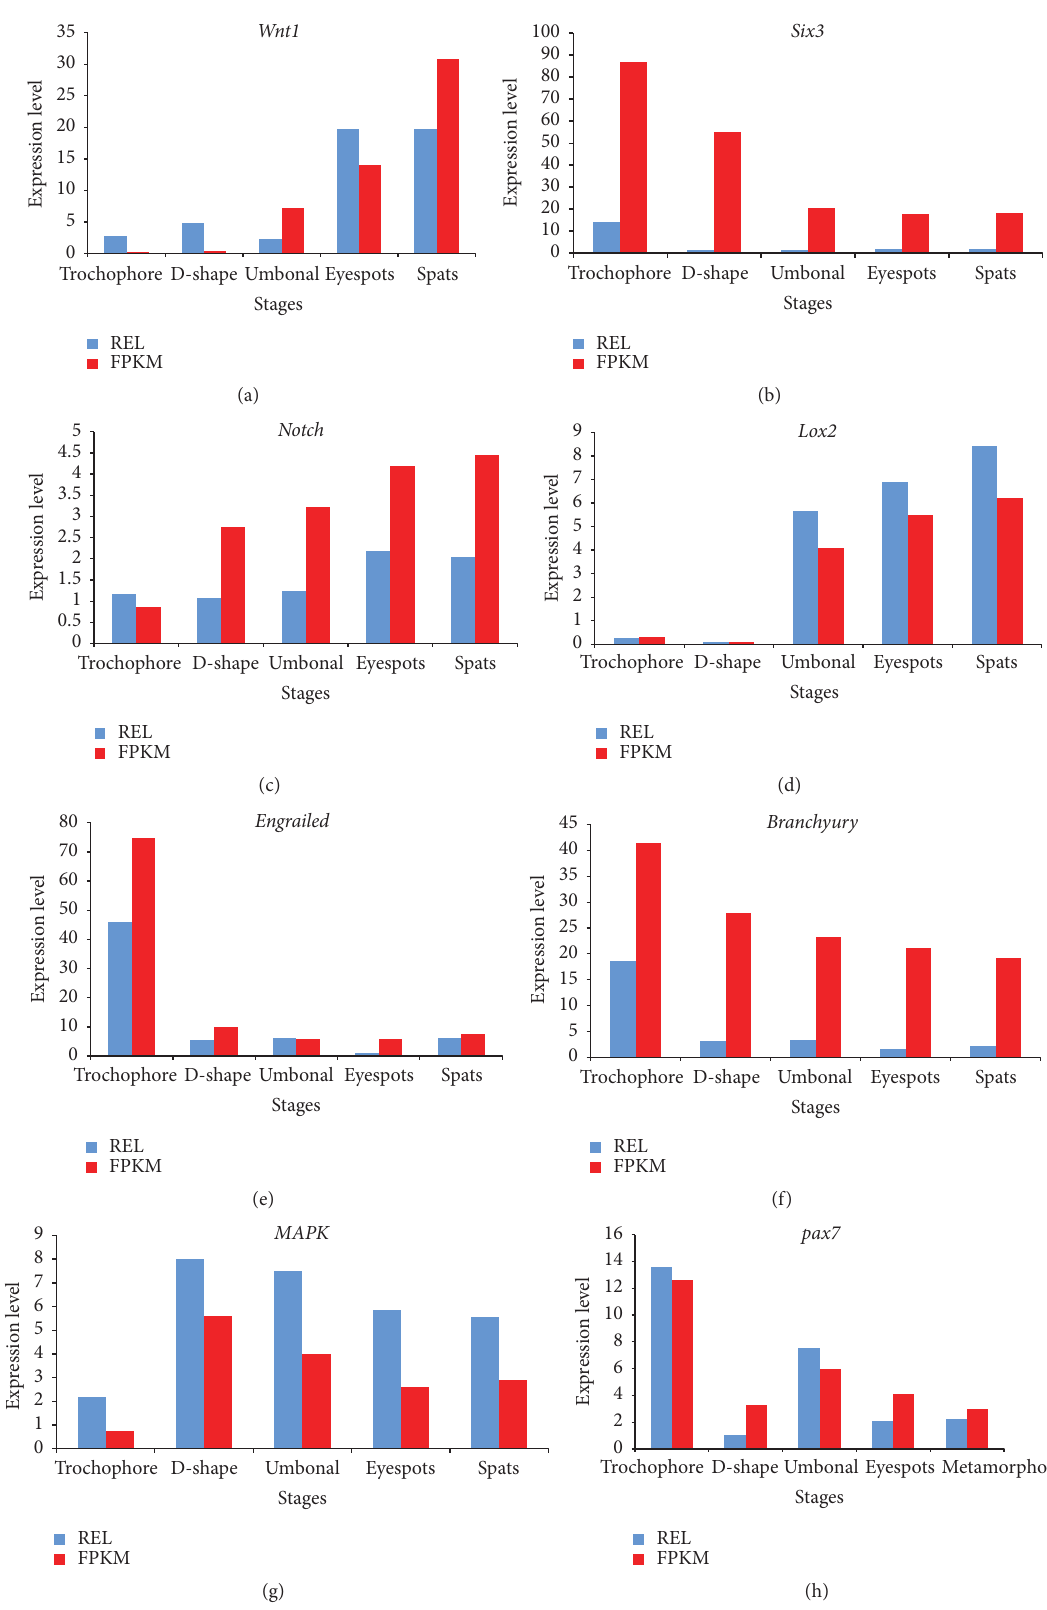
Figure 10: Expression changes in (a) Wnt1 , (b) Six3 , (c) notch , (d) lox2 , (e) engrailed , (f) branchyury , (g) MAPK , and (h) pax7 in trochophore, D-shaped, umbonal, eyespots, and spats larval stages by